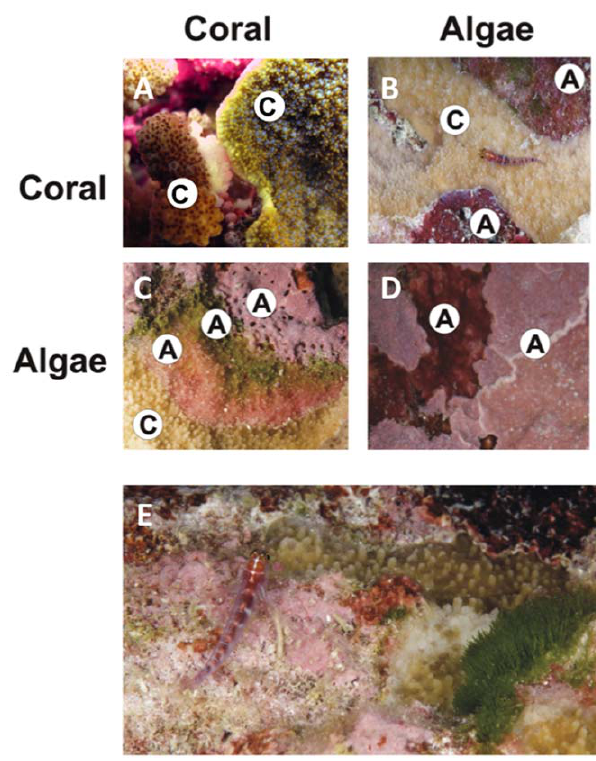
Figure 1. Examples of boundaries between coral and algae. A) Pocillopora sp. vs. Montipora sp., B) algae vs. Montipora sp., C) Montipora sp. and various algae, D) crustose coralline algae vs. crustose coralline algae, and E) diverse interactions including coral, fleshy algae, crustose coralline algae, and other invertebrates.